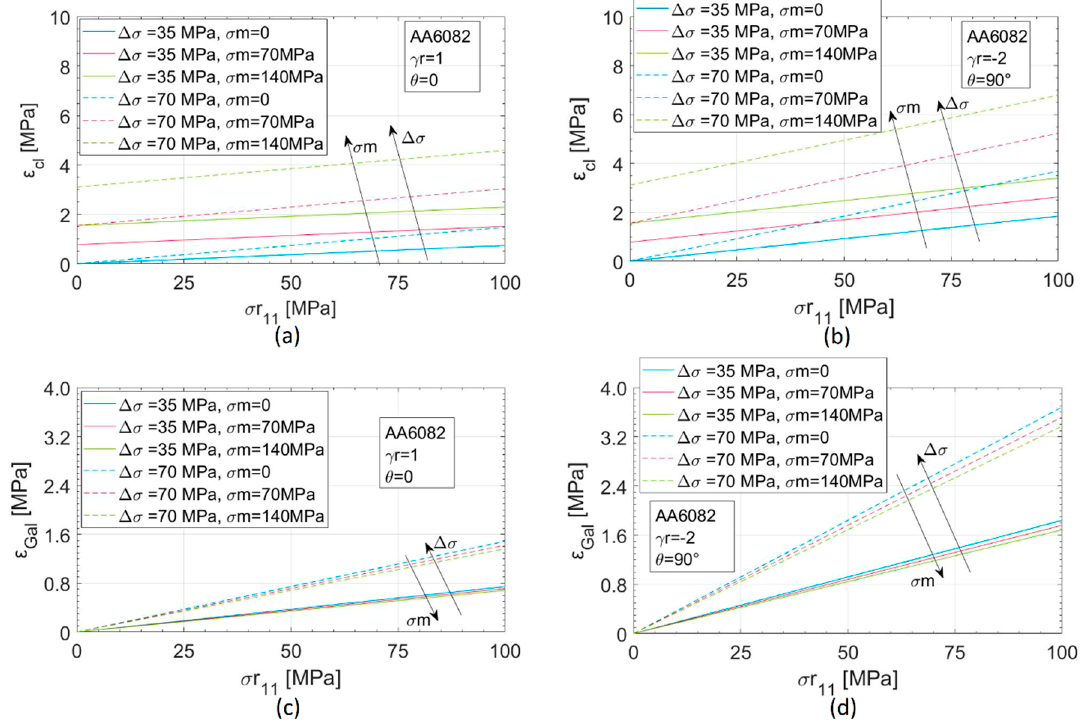
Figure 6. Parameter ε as function of σ r11 for the AA6082 alloy: ( ε cl ) for the classical technique and ( ε Gal ) for the method proposed in Reference [17] are compared for the case of ( a , c ) for low and ( b , d ) for high residual stresses effect.